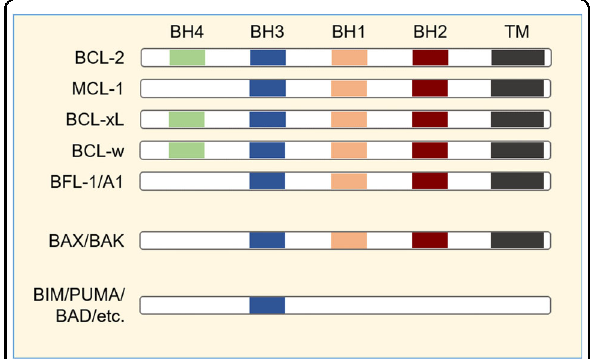
Fig. 1 Members of the BCL-2 family of proteins share BCL-2 homology (BH) domains and are grouped according to function and structure. Figure not to scale. TM transmembrane